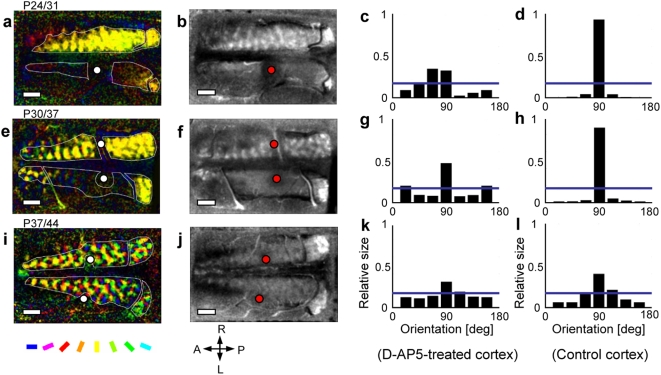
Effect of NMDA receptor antagonist on orientation plasticity.(a), (e) and (i): orientation polar maps constructed immediately after concurrent GR and D-AP5 infusion for 1 week in three kittens for different onset ages of GR. (b), (f) and (j): response-strength maps constructed by summing all single-orientation maps in the respective animals. Brightness indicates response strength. White dots in a, e and i, and red dots in b, f, and j indicate locations of infusion centers of D-AP5 in the left-hemisphere or saline in the right hemisphere. (c), (g) and (k), and (d), (h) and (l) show orientation histograms for the D-AP5-treated visual cortex and for the control visual cortex, respectively. Other conventions are as in Fig. 1.